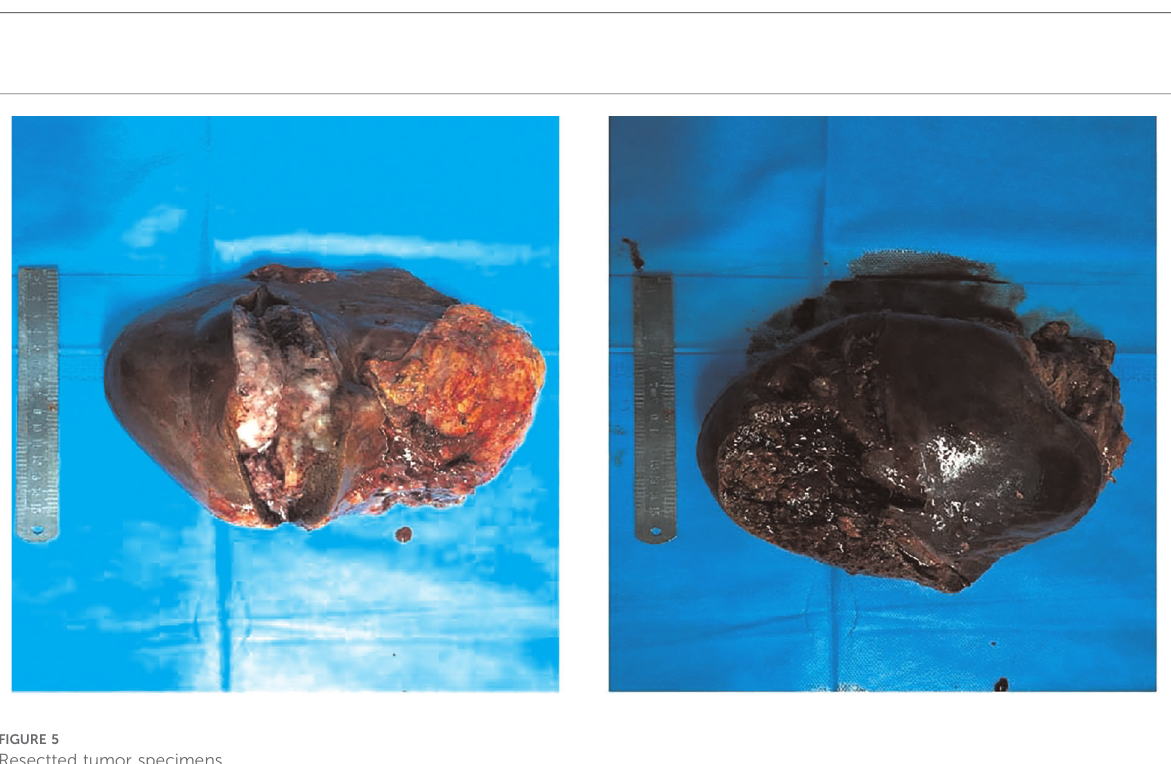
FIGURE 4 ( A ) resected partial diaphragm and lung tissue. ( a ) The right lung exposed after removal of part of the diaphragm. ( b ) Diaphragm. ( c ) Remnant of right hepatic vein. ( d ) Remnant of middle hepatic vein. ( B ) Diaphragm after repair.